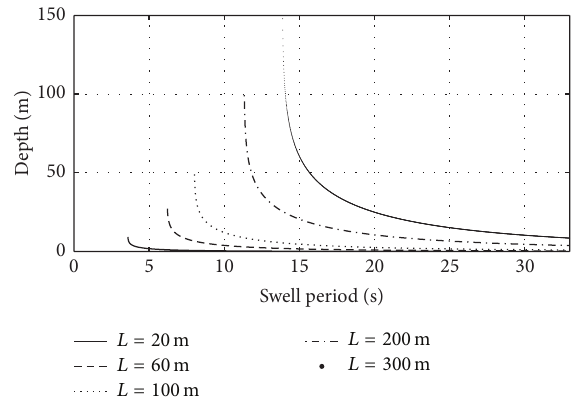
Figure 3: Sea water depth as function of swell period for different values of swell wavelength, 𝐿 , in the range [20; 300]m, according to thelineardispersionrelationstartingfromintermediatewater depth up to shoreline.